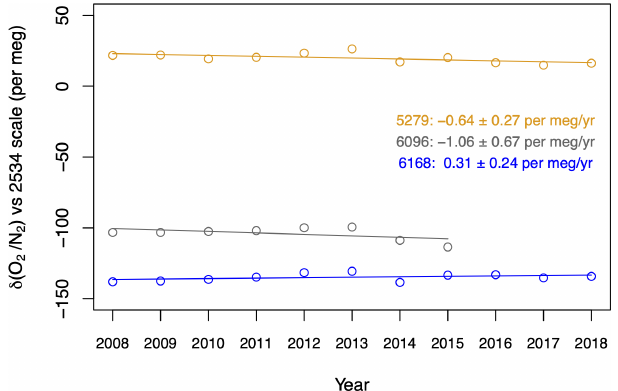
Figure 4. Annual averages of WTs 5279, 6096, and 6168 (points) from 2008 to 2018, against the CIO scale. The fitted trends (lines) and the values of their slopes are also plotted.